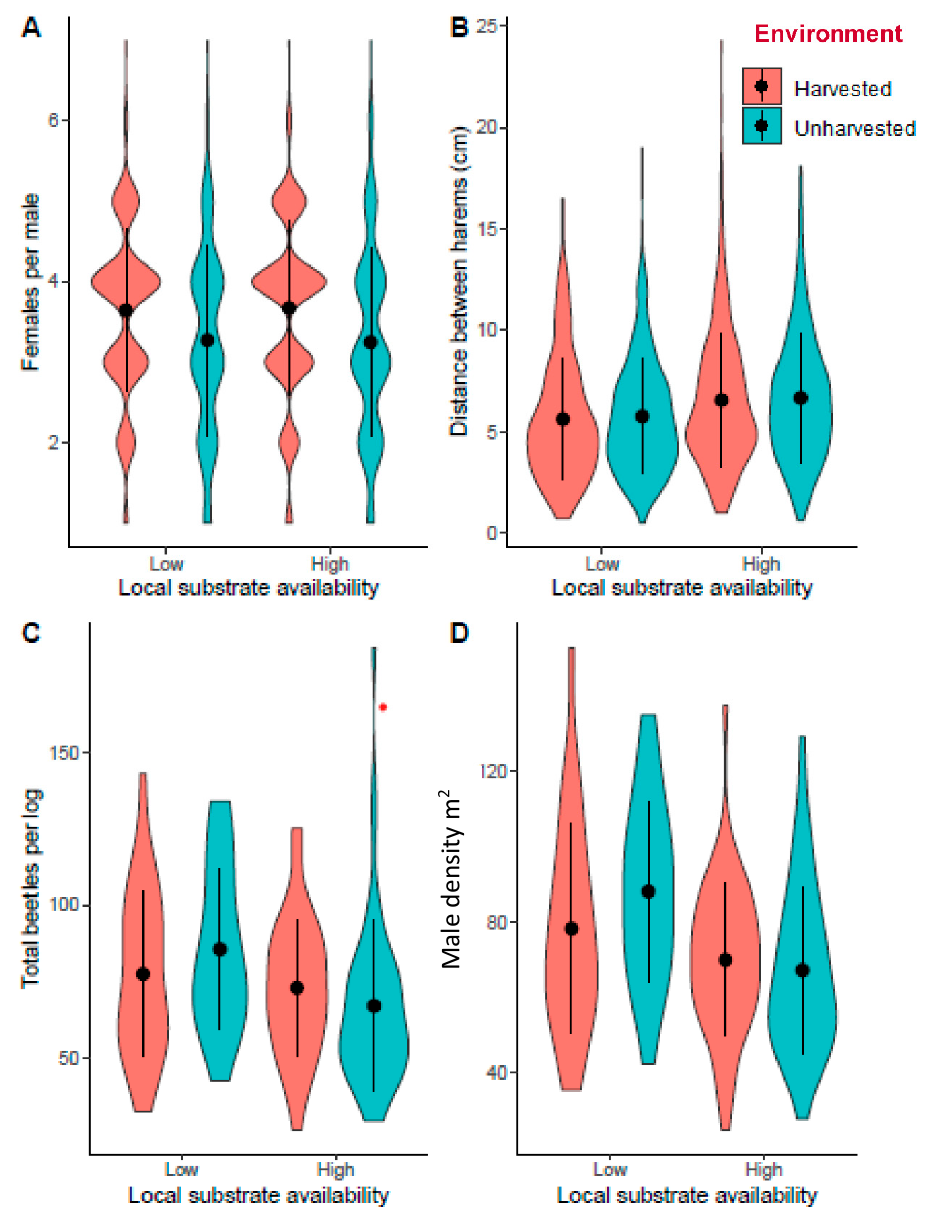
Figure 3. Violin plots indicating the spread and ( A ) mean ( ± SD) number of females per male (harem size), ( B ) mean ( ± SD) distance to the nearest harem (male nuptial chamber), ( C ) mean total number of beetles (males and females) per log ( ± SD), and ( D ) mean density ( ± SD) of males on a log (number of males per m 2 ) in relation to local substrate availability (high = 10 logs/pile, low = 5 logs/pile) in harvested and unharvested pine plantations. Table 1. Best generalised linear mixed model selected to predict the total number of beetles found in a log. Model estimates for categorical predictors are those for the condition represented in parentheses.